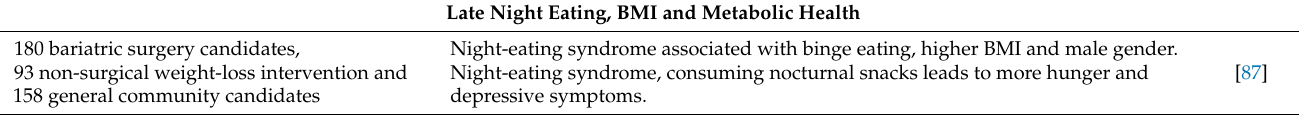
Figure 2. Master (blue) and peripheral clocks (pink) alignment is key to optimal metabolic health. Chronodisruption by various means leads to misalignment of circadian rhythms and has health consequences. Chrononutritional approaches have the ability to reverse deleterious chronodisruptive rhythms. The dotted line represents MESOR (midline estimating statistic of rhythm). Table 2. A summary of evidence establishing the role of chronodisruption by mistimed eating habits and associated BMI and metabolic health outcomes.